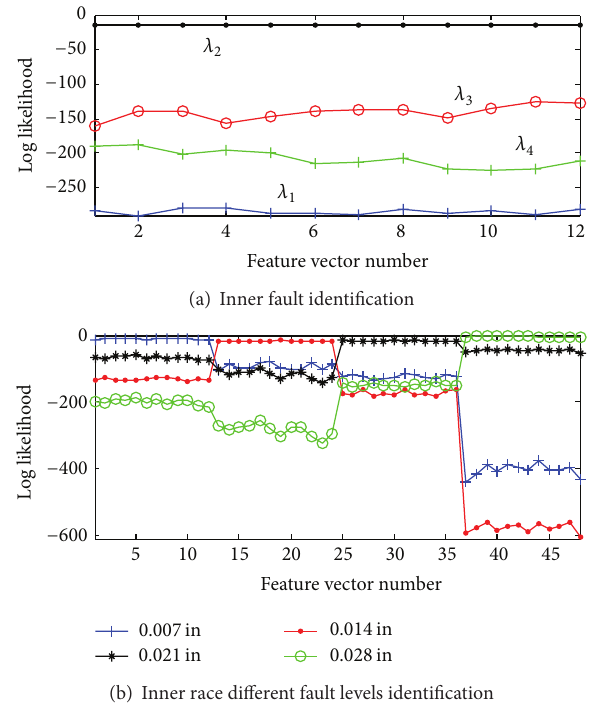
Figure 3: Bearing performance degradation assessment using pre- sented architecture 1.